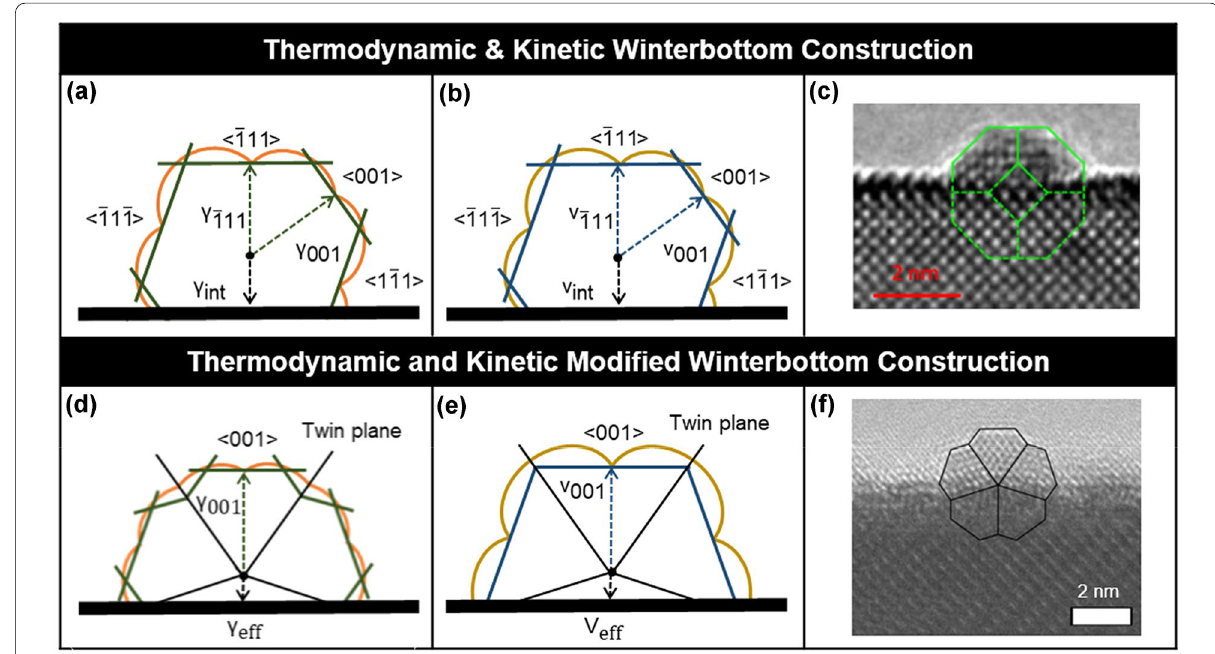
Fig. 4 Winterbottom and related constructions for supported crystals. Gamma and v-plots viewed along < 110 > for the ( a ) thermodynamic, ( b ) kinetic, ( d ) thermodynamic modified and ( e ) kinetic modified with re-entrant enhancement Winterbottom constructions λ and v correspond to surface energy and growth velocity, respectively, and γ eff and v eff correspond to the effective interface energy and effective growth velocity, respectively. The twin energy/growth velocity is considered to be negligible. TEM images of (c) a single Pt crystal grown on a SrTiO 3 nanocube, adapted with permission from [46], and ( f ) a five-fold Au Marks decahedron grown on a faceted LnScO 3 nanoparticle, adapted with